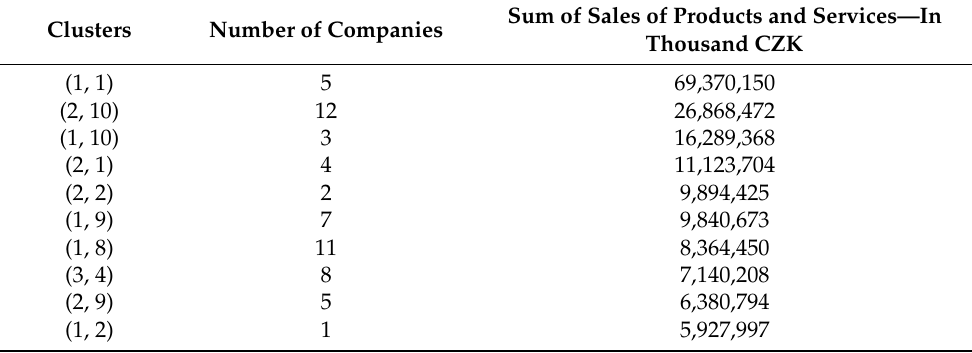
Table 17. Table of ten clusters with the highest total sum of fixed assets for the year 2015. Clusters